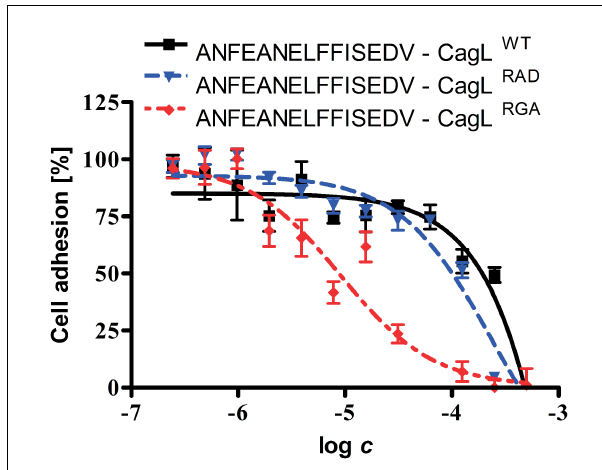
FIGURE 2 | Dose–response curve of a linear RHS motif-containing peptide, inhibiting binding ofWM-115 cells to immobilized CagL WT and mutants. TheWM-115 cells were pre-incubated in different concentrations of the linear 15-mer peptide ANFEANELFFISEDV, which mimics the exposed RHS motif of CagL. Purified CagL WT and the CagL RAD and CagL RGA mutants were immobilized on plastic surface followed by addition of the WM-115 cells. After 1h of co-incubation, the amounts of attached cells were determined.The data were evaluated using non-linear fit for the